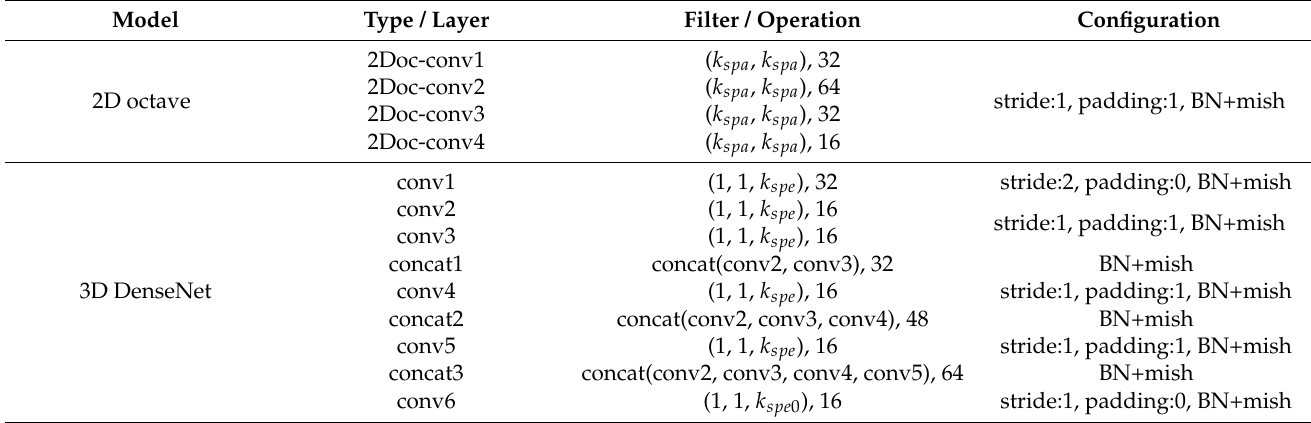
Table 5. Network parameters settings for 2D octave and 3D DenseNet in the MOCNN